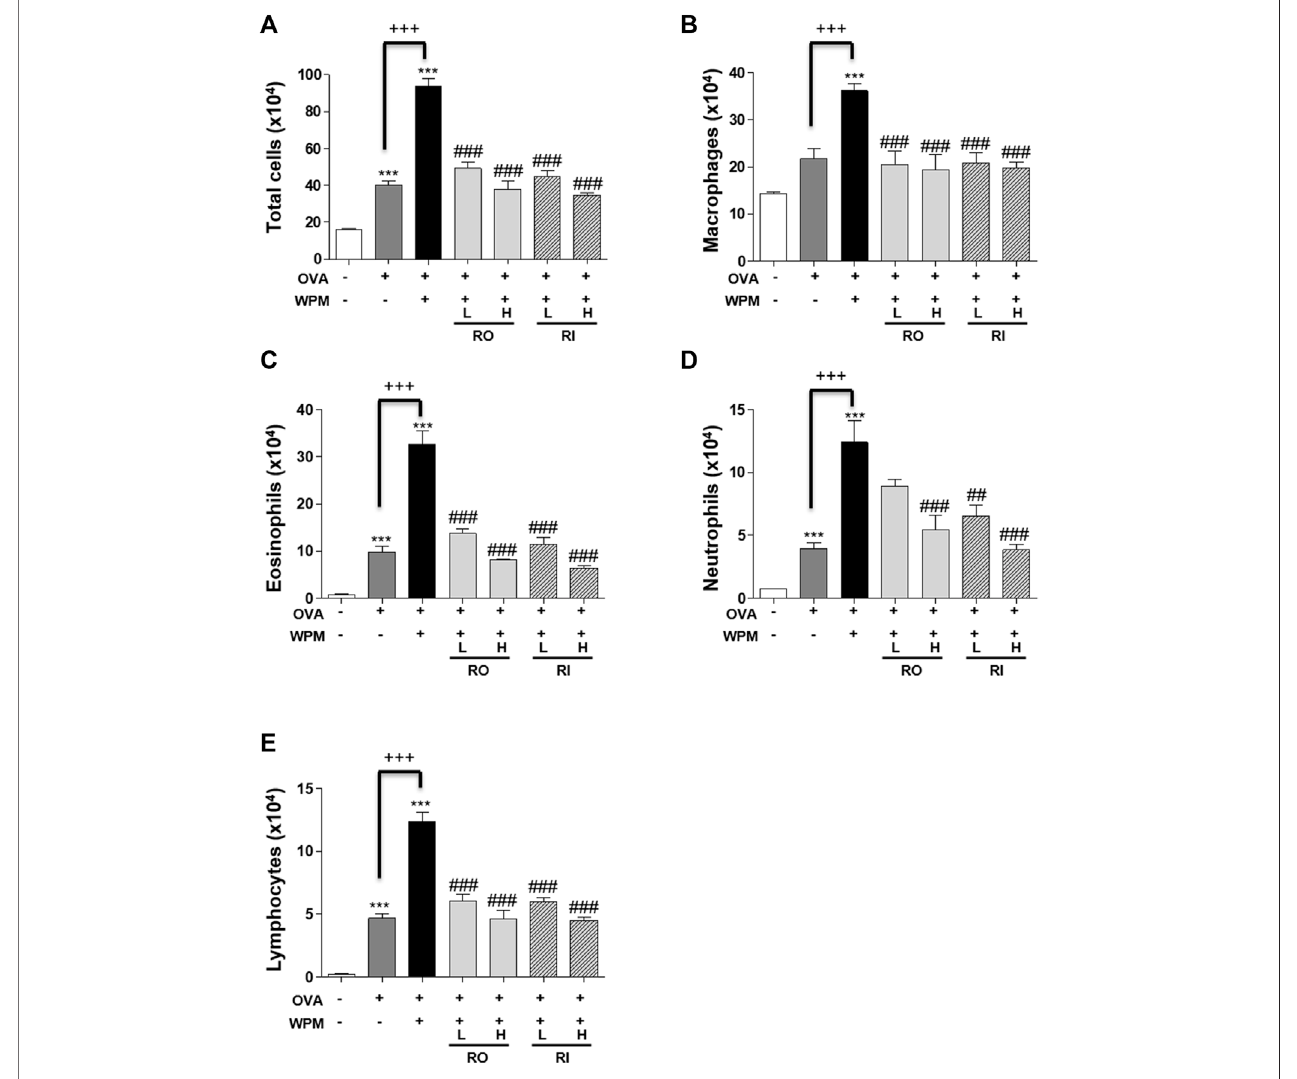
FIGURE3| TheeffectsofRLonin fl ammatory cellin fi ltrationinaWPM-exacerbatedmousemodelofasthma.Cellpopulationof (A) totalcells, (B) macrophage, (C) eosinophils, (D) neutrophils and (E) lymphocytes in BALF. All data are presented as the mean ± SEM. n = 5/group. *** p < 0.001 compared with the control group; ## p < 0.005 and ### p < 0.001 compared with the OVA + WPM group; +++ p < 0.001 compared with the OVA group.